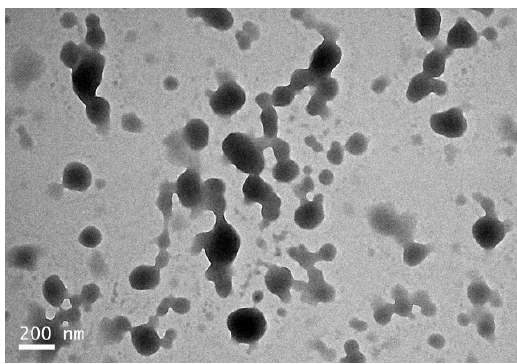
Figure 4. Transmission electron microscopy (TEM) image of the freshly ‐ prepared Cur ‐ loaded zein ‐ caseinate ‐ pectin particles.